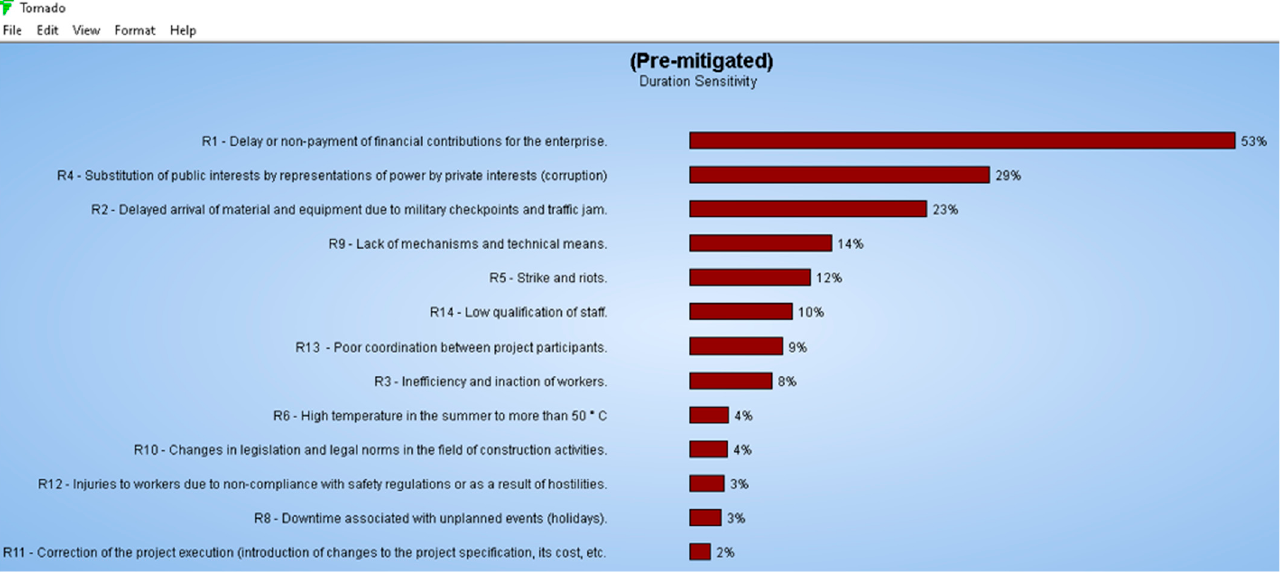
Figure 7. Tornado sensitivity plot.